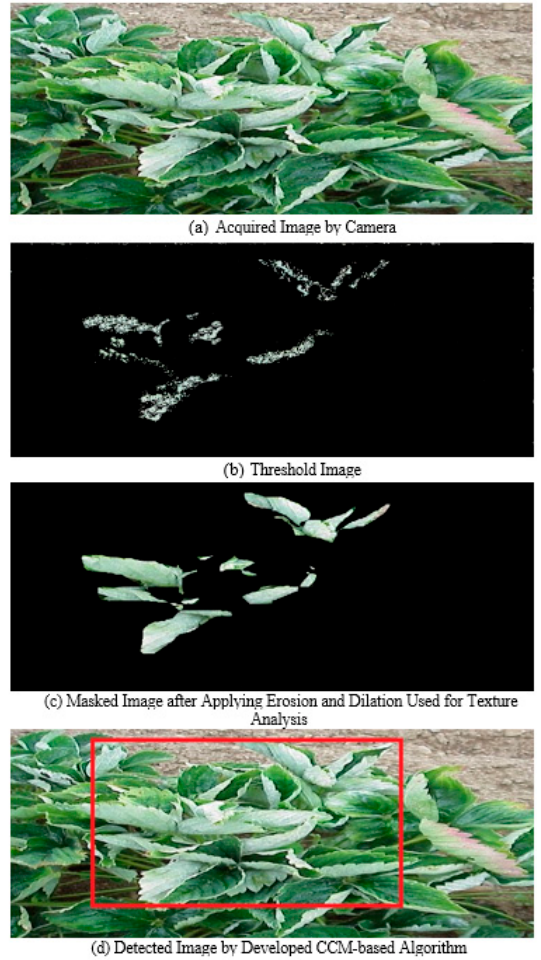
Figure 7. Strawberry powdery mildew disease detection in real-time field condition: ( a ) acquired image, ( b ) threshold image, ( c ) masked image, and ( d ) PM detected